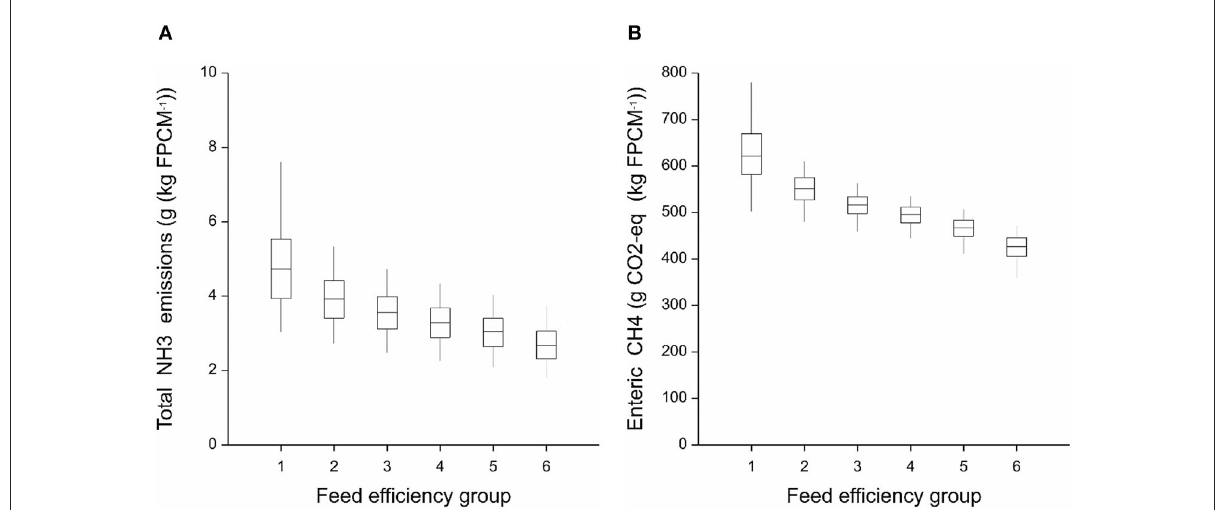
FIGURE3 Boxplots of indicator values per group of farms. (A) Total NH 3 emissions, expressed in g NH 3 per kg milk; and (B) Enteric CH 4 , expressed in g CO 2 -eq per kg milk. The 12.770 farms were ordered in descending order of feed efficiency (expressed in kg feed DM needed per kg milk produced) and then divided in six “Feed efficiency groups” according percentile values (0-10; 10-30; 30-50; 50-70; 70-90; and 90-100%).